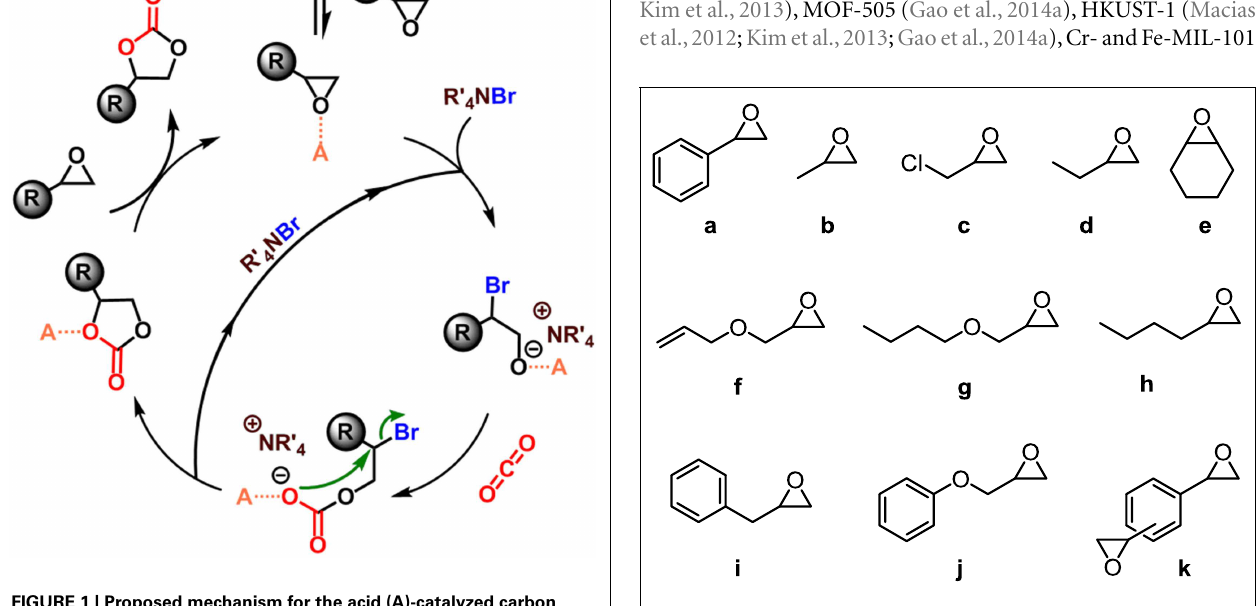
FIGURE 2 | Epoxides utilized for the cycloaddition reaction of CO 2 catalyzed by MOFs and covered in this review